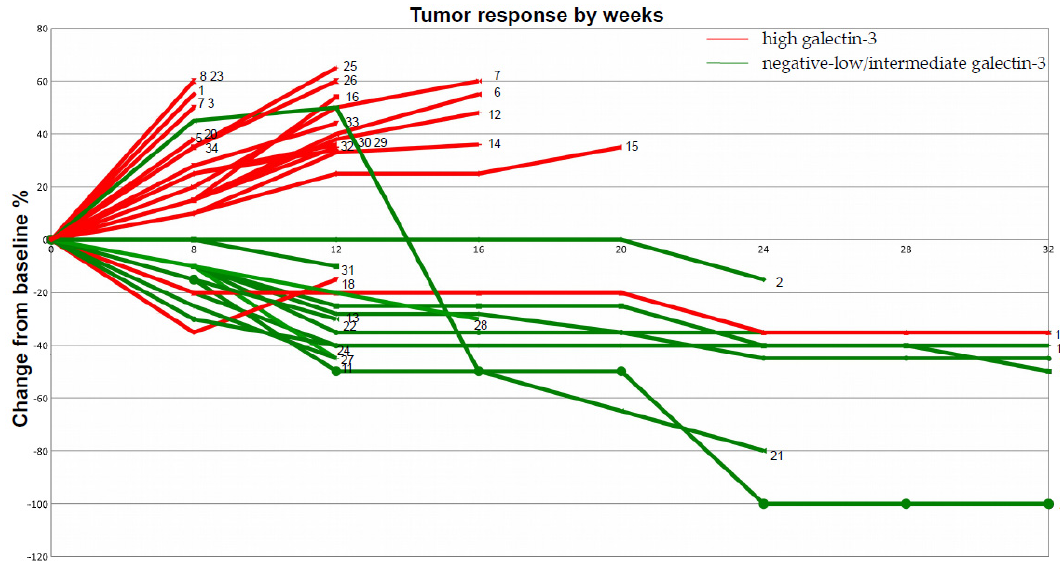
Figure 2. Spider plot of tumor response to checkpoint inhibitor therapy. The clinical response of each patient listed in Table 1 is plotted in this picture to better correlate galectin-3 expression with tumor sensitivity to pembrolizumab during follow-up. According to Table 1: patients with high galectin-3 expression (red lines), the large majority of which showed disease progression after 20 weeks of follow-up; patients with negative–low/intermediate galectin-3-expressing tumors (green lines) showing significant sensitivity to pembrolizumab. One patient had a complete response (n°4);